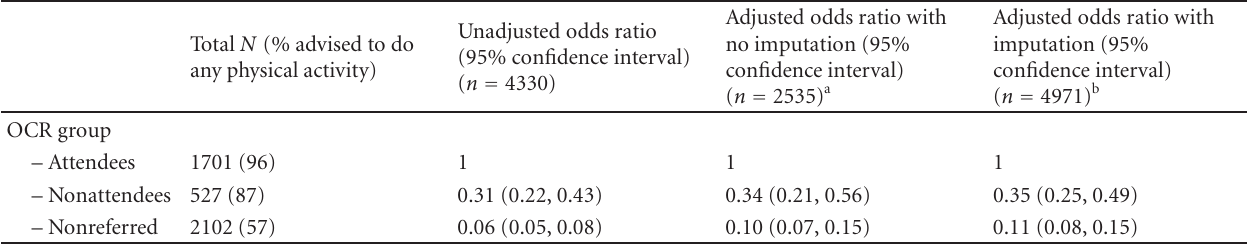
Table 3: Association between participation in outpatient cardiac rehabilitation and self-reported receipt of advice to participate in physical activity.